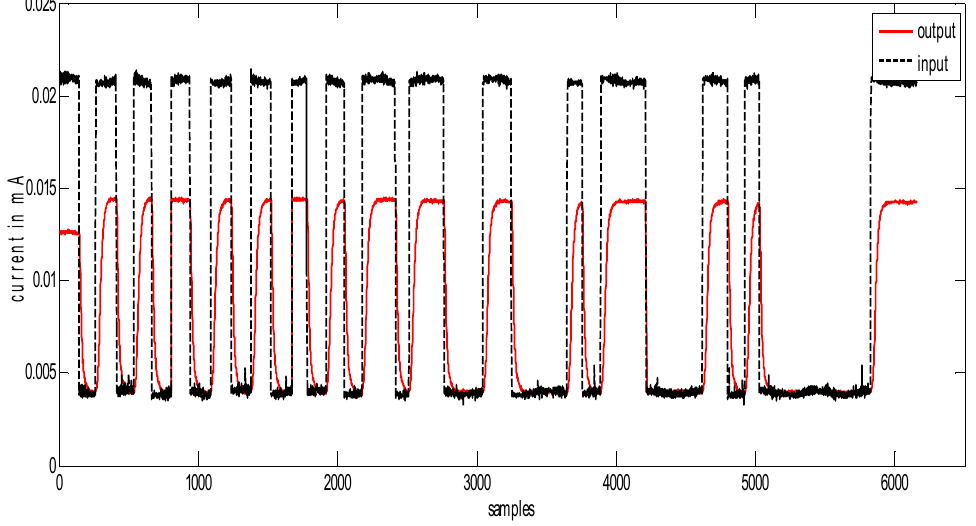
Figure 6. Response plot used for identification.